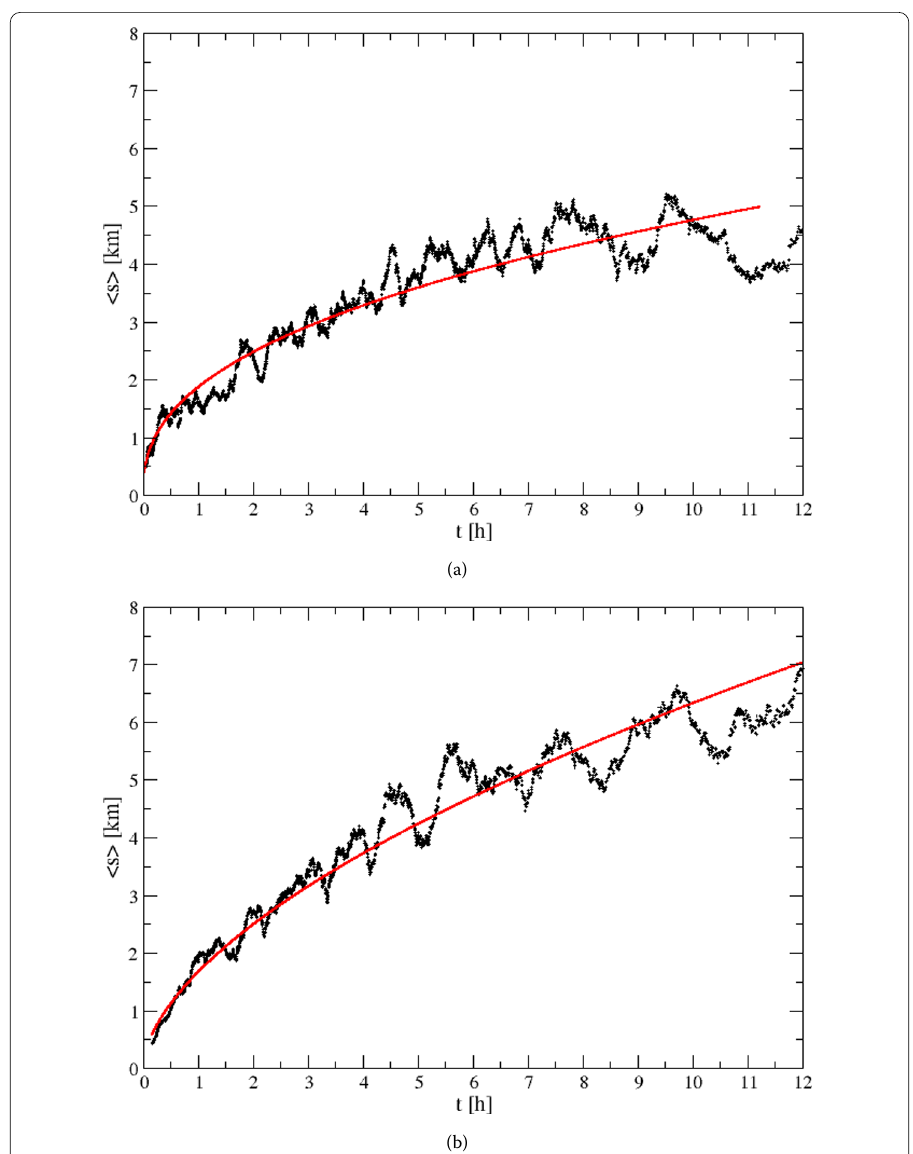
Figure 6 Relation between the average path lengths (cid:4) s (cid:5) and the mobility times: the left picture refers to the Carnival dataset and the right picture to FestadelRedentore dataset. The plots are obtained performing a running average of length 100 on the ( t , s ) data. The continuous line is the result of an power law interpolation (cfr. Equation (1)) with exponents α = 0.41 in the first case and α = .58 in the second one, whereas the proportionality coefficient is (cid:2) 1.7 in both cases